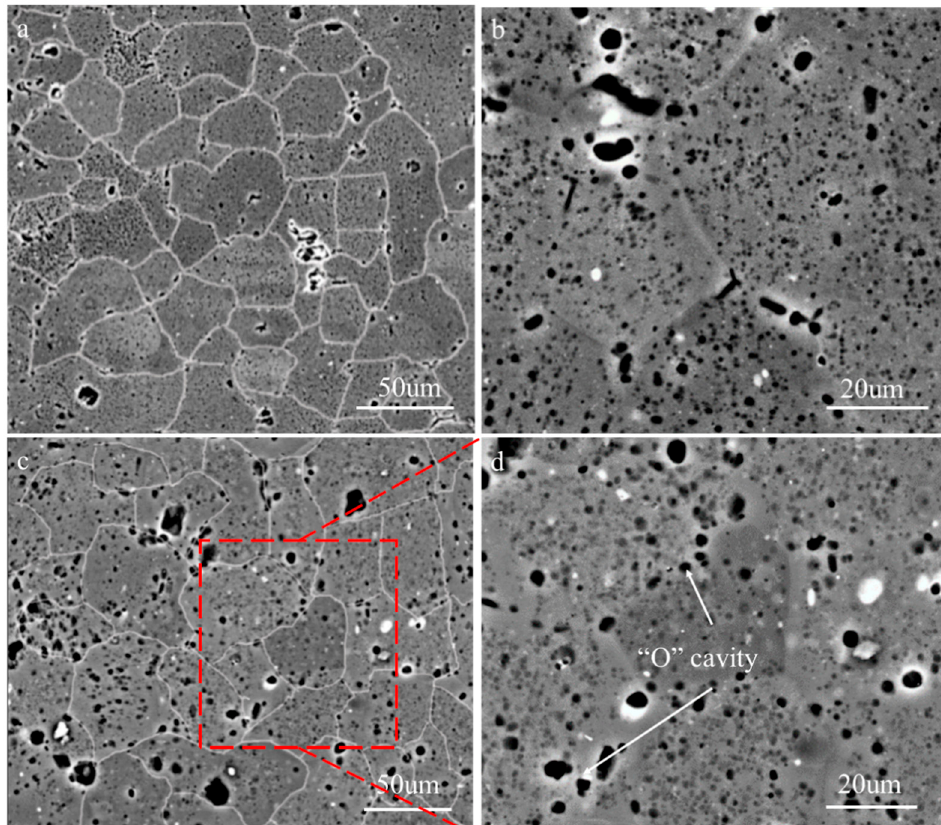
Figure 18. Microstructure of ( a , b ) the preforming structure; ( c , d ) final